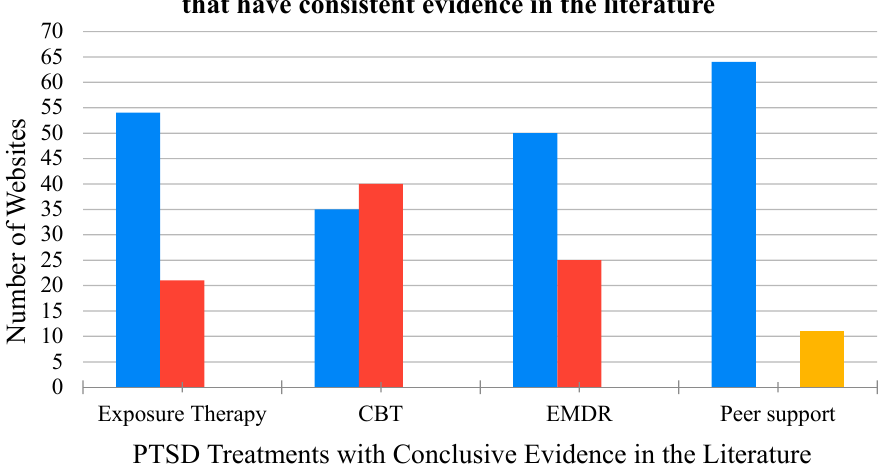
Figure 3. The number of websites that agreed or disagreed with the evidence-based statements for the potential treatments that have inconclusive evidence to support their e ff ectiveness. Additionally included are the number of studies that did not mention the potential treatments. All studies that disagreed with evidence-statements had a positive focus and only presented the evidence to support the treatment e ff ectiveness. None of the websites disagreed with a negative focus, meaning that the unsuccessful treatment of PTSD was not mentioned.